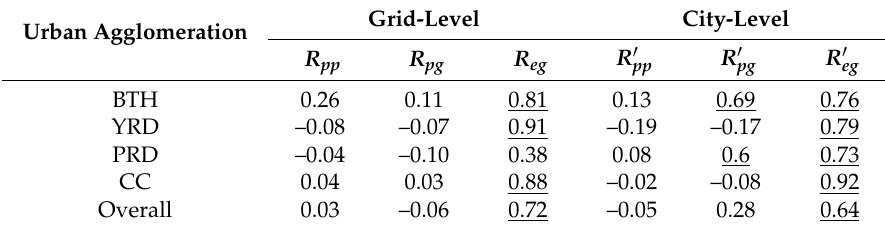
Table 2. Correlation coefficient of PM 2.5 concentrations, population, GDP, population exposure in urban